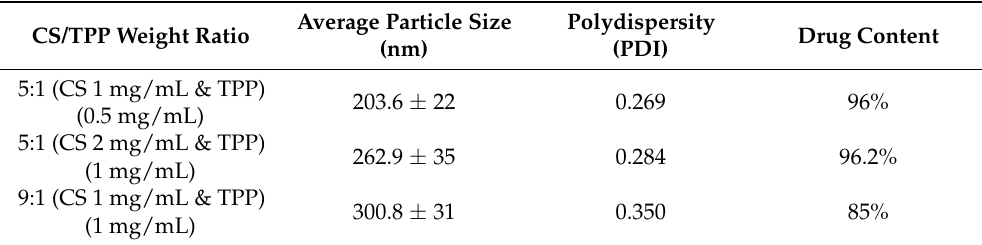
Table 2. Particle Size, Polydispersity Index, and Drug Content of CPX-Loaded Chitosan Nanoparticles Stored at Room Temperature after 30 Days.